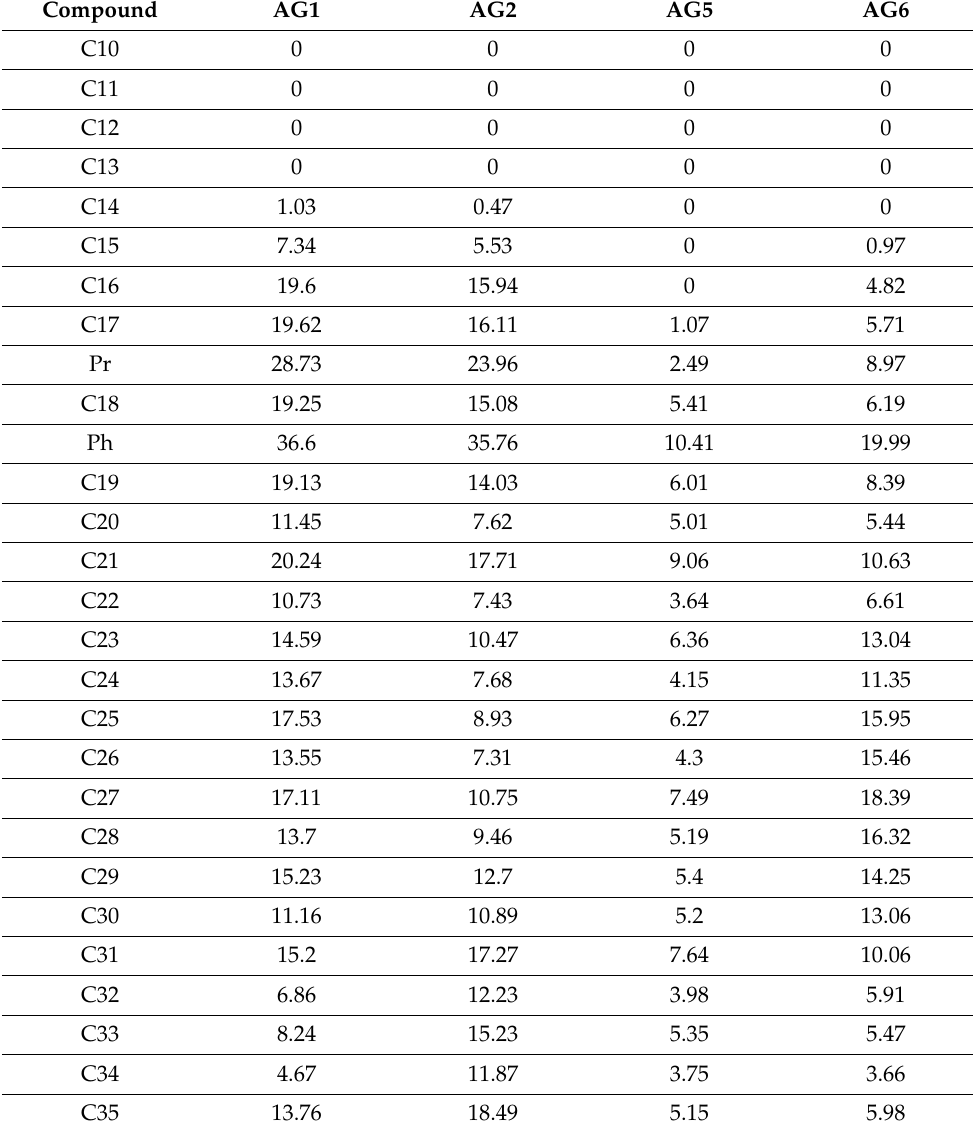
Table 6. Concentrations of n-alkanes (ppm) through the GC-MS analysis for samples.